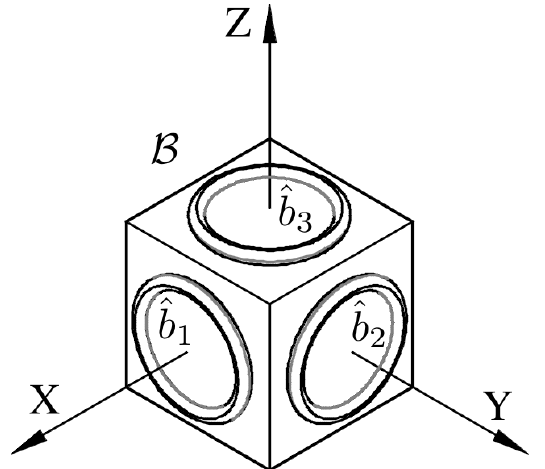
Figure 1. Satellite equipped with 3 fluid rings. The body frame attached to the satellite is called B and the unit vectors are ˆ b 1 , ˆ b 2 , and ˆ b 3